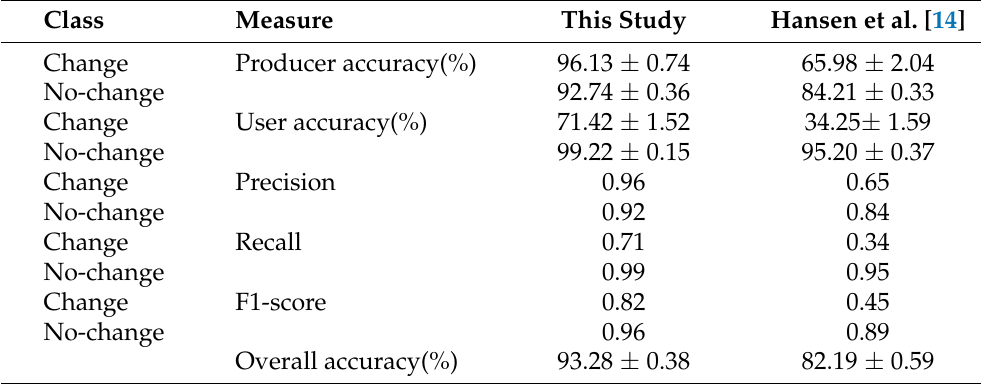
Table 12. Model performance evaluation metrics for potential forest changes in 2019 at a 95% confidence interval, compared to global forest change analysis version 1.7 of 2019 Hansen et al. [14].